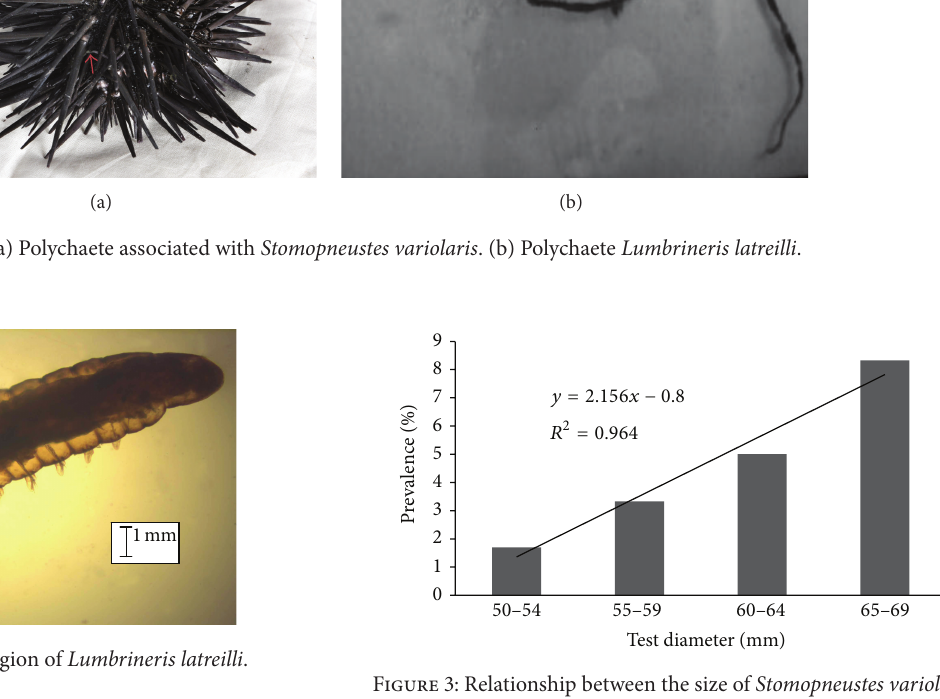
Figure 3: Relationship between the size of Stomopneustes variolaris and its infestation prevalence by Lumbrineris latreilli